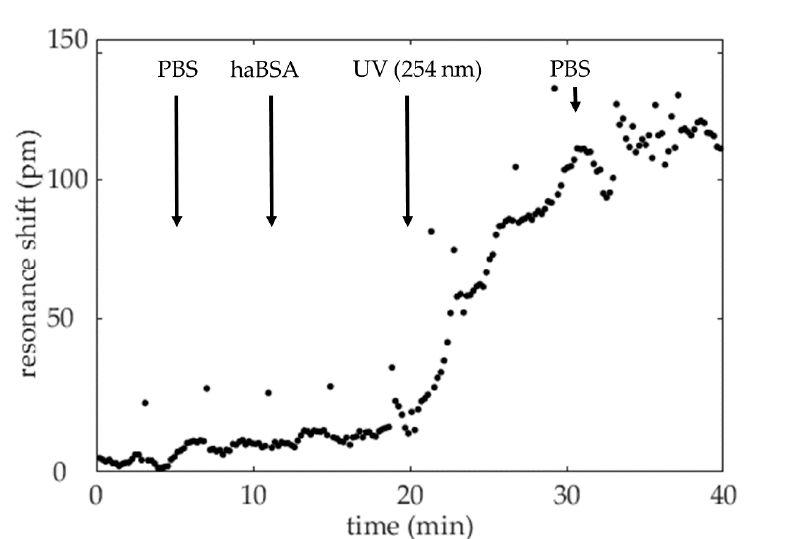
Figure 5. Temporal evolution of the PBG spectral shift during the light-assisted haBSA immobilization process. haBSA are injected at 10-minutes and UV light source is switched on at 20-minutes.